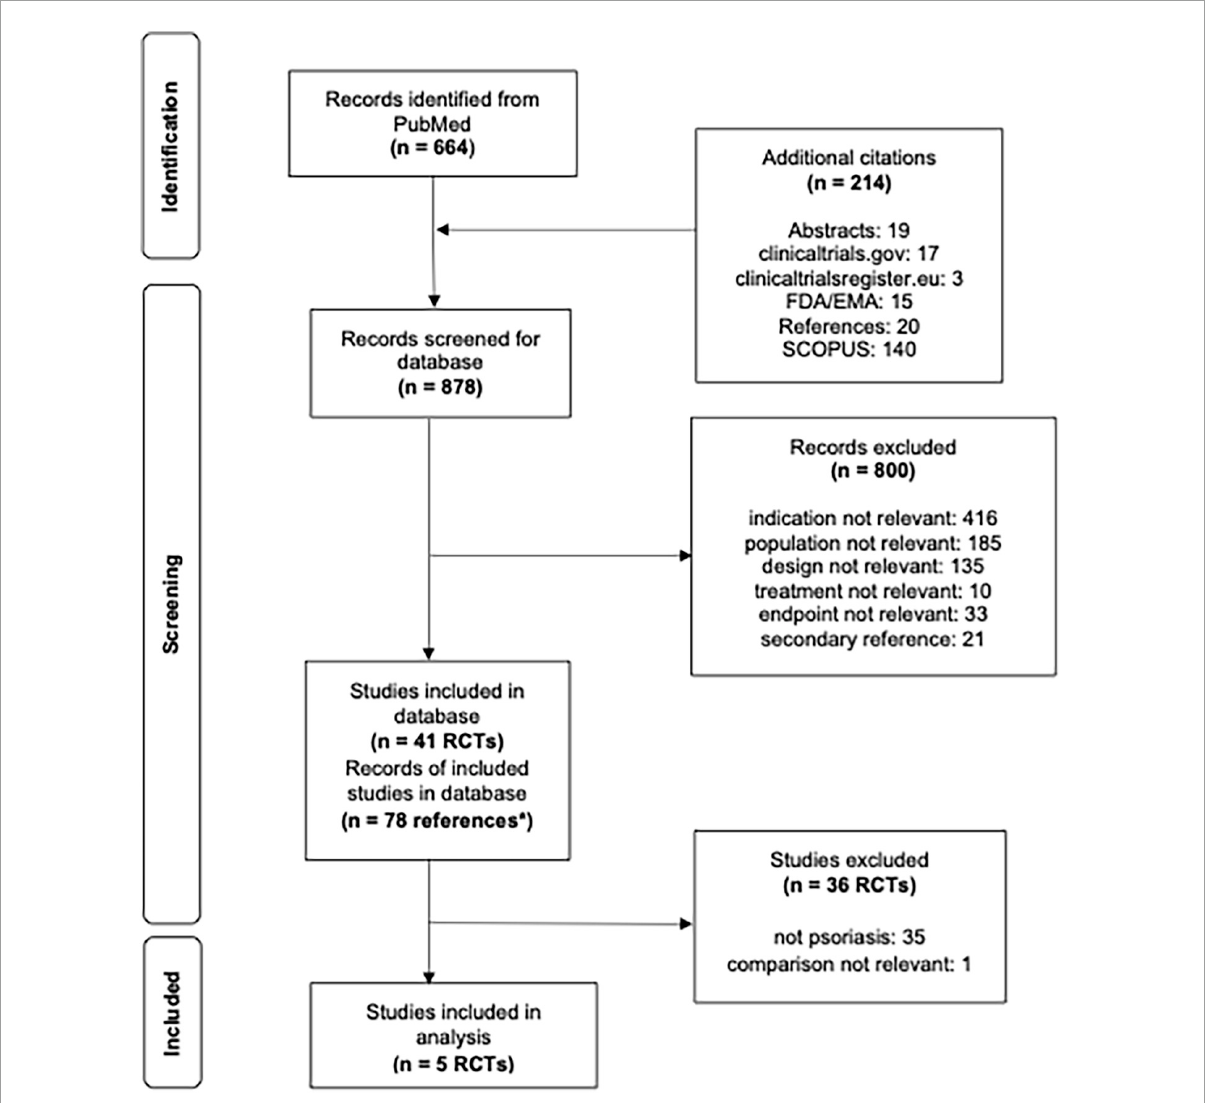
FIGURE1 Flowsheet literature review and pediatric study selection for analysis. * n = 78 correspond to multiple references to a single study, i.e., more than one journal article, clinicaltrials.gov and/or regulatory